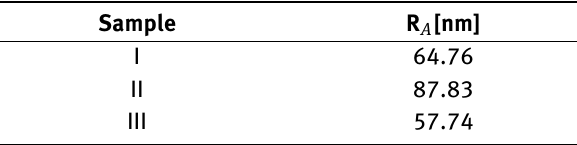
Figure 2: Spherical changes on the surface of the accelerated aged samples (2.5 h ageing). Table 2: Measured surface roughness (R A ) of accelerating aged